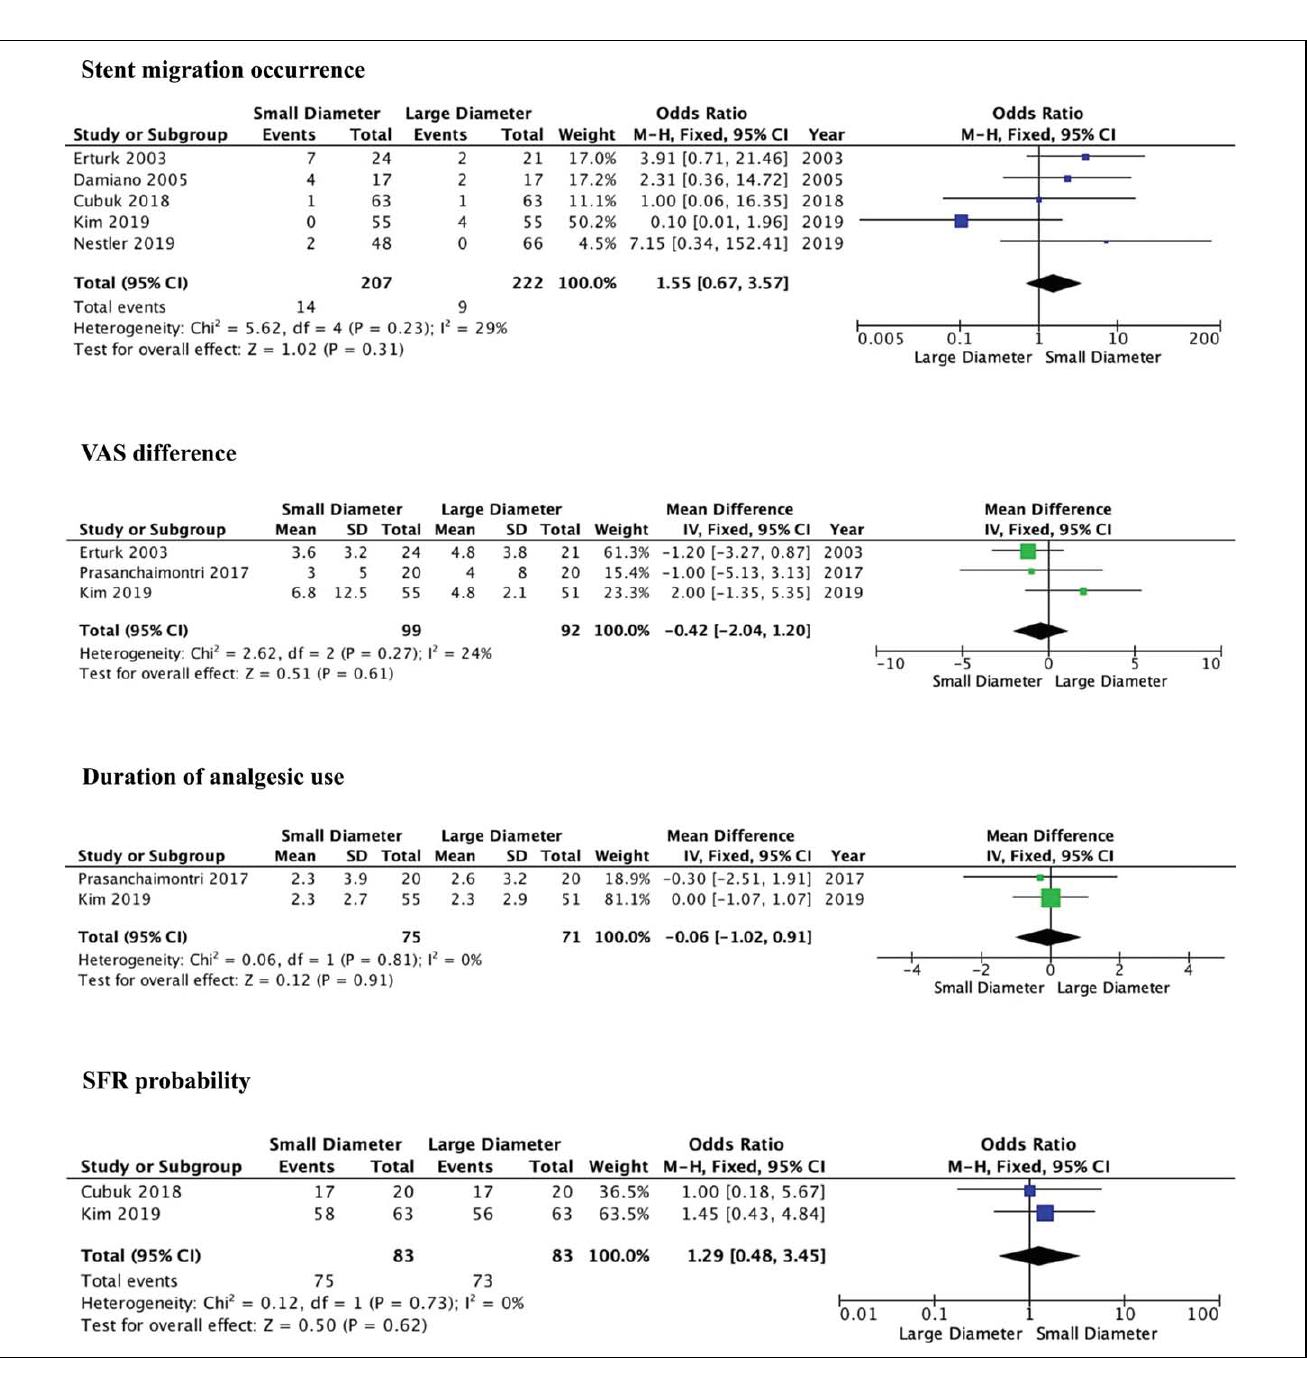
4. Forest plot of stent migration occurrence, VAS difference, duration of analgesic use, and SFR probability between the